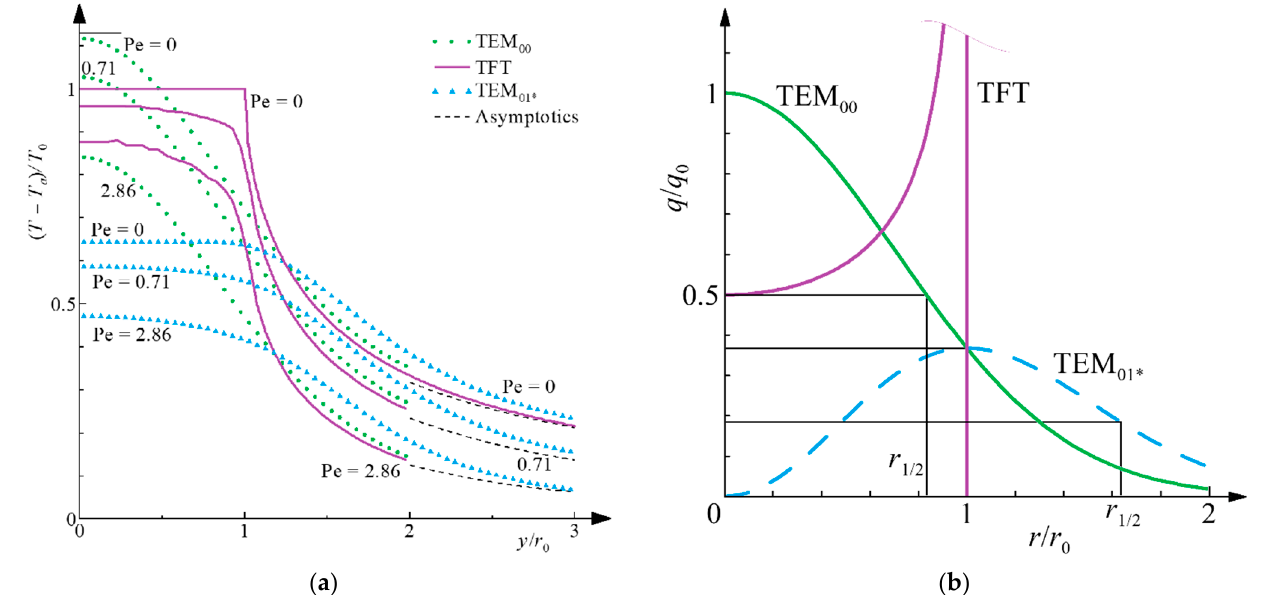
Figure 4. Maximum temperature T on the target surface z = 0 versus distance y from the scanning axis ( a ); the testing profiles ( q / q 0 ) and estimation of their radii at half-width r 1/2 ( b ).